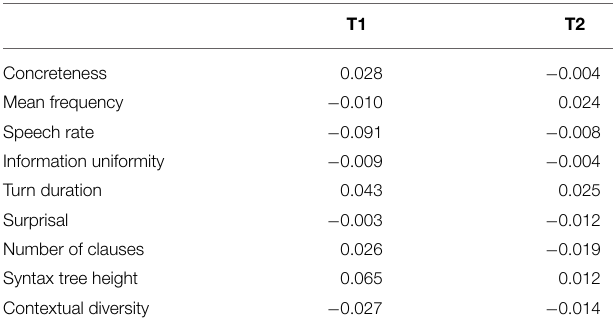
TABLE 2 | The Pearson correlation between processing measures and FTO for T1 and T2.